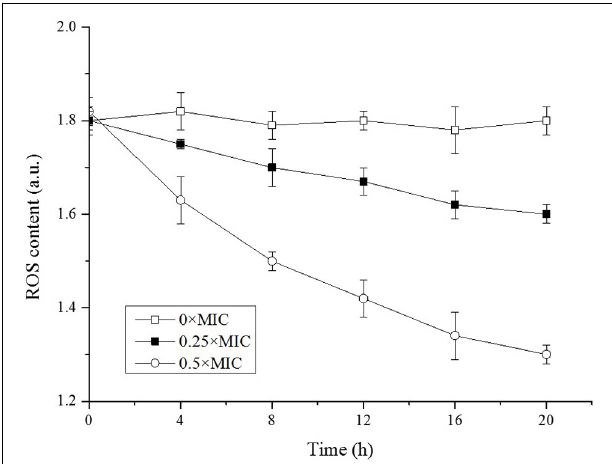
FIGURE 6 | Reactive oxygen species (ROS) levels in Salmonella exposed to different doses of CGA.